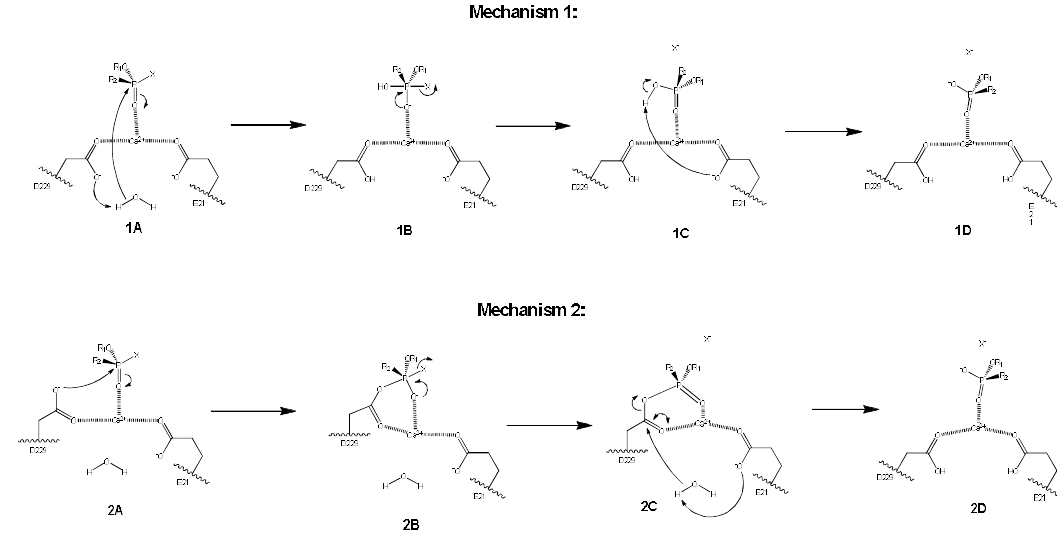
Figure 3. OP hydrolysis reaction pathways proposed for DFPase action. Mechanism 1: it is shown the participation of a molecule of water as nucleophile with assistance of both Asp229 (D229) and Glu21 (E21) residues. In 1A, the hydroxide ion formed with the assistance of Asp229 attacks the OP leading to the pentavalent intermediate. In 1B, this intermediate collapses, hence, producing the leaving group X − . In 1C, the Glu21 residue removes a proton of the OP, leading to 1D. Mechanism 2: only the Asp229 residue participates as nucleophile on the reaction. In 2A, Asp229 attacks the OP. In 2B, the pentavalent intermediate collapses. In 2C, a molecule of water hydrolyses the intermediate with the assistance of Glu21, leading to 2D, which is the same structure as 1D. In Mechanism 2, the tetrahedric intermediate was not shown for clarity reasons. In both mechanisms, the X − leaving group is stabilized by other residues (not shown). Adapted from references [7,11–13].